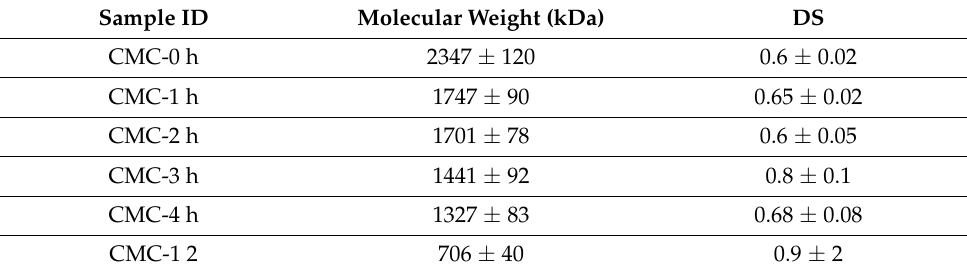
Table 1. Molecular weight and degree of substitution of CMC samples.